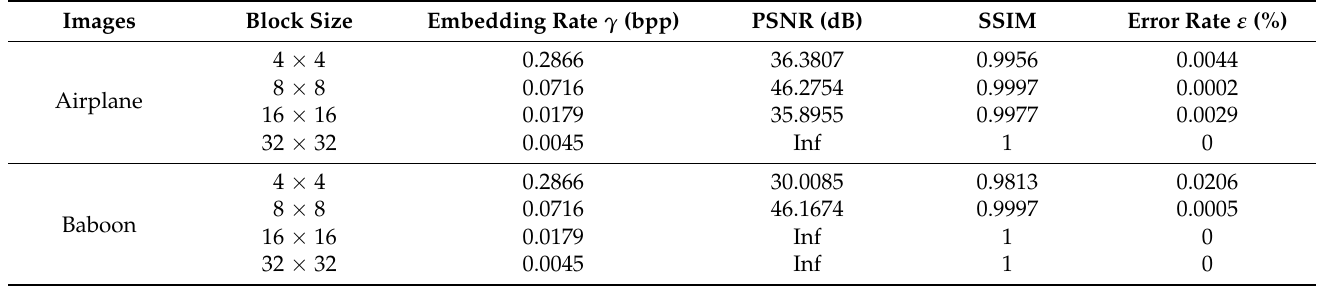
Table 1. Performances when number of sub-blocks = 4 and codebook size =